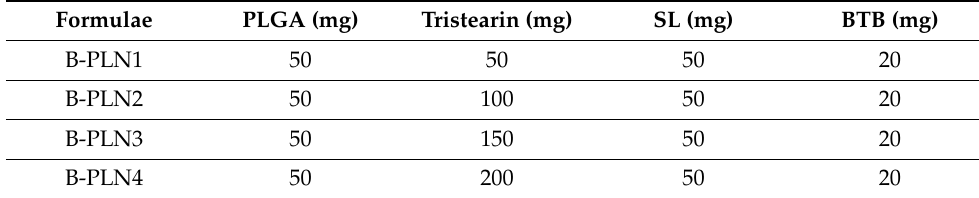
Table 3. Composition of developed lipid-polymer hybrid NPs (B-PLN1 to